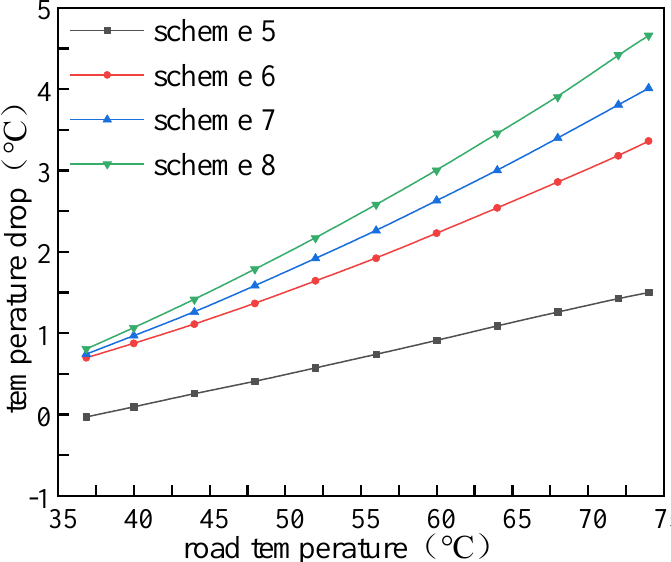
Figure 10. Temperature drop with different PCM mixing ratios.